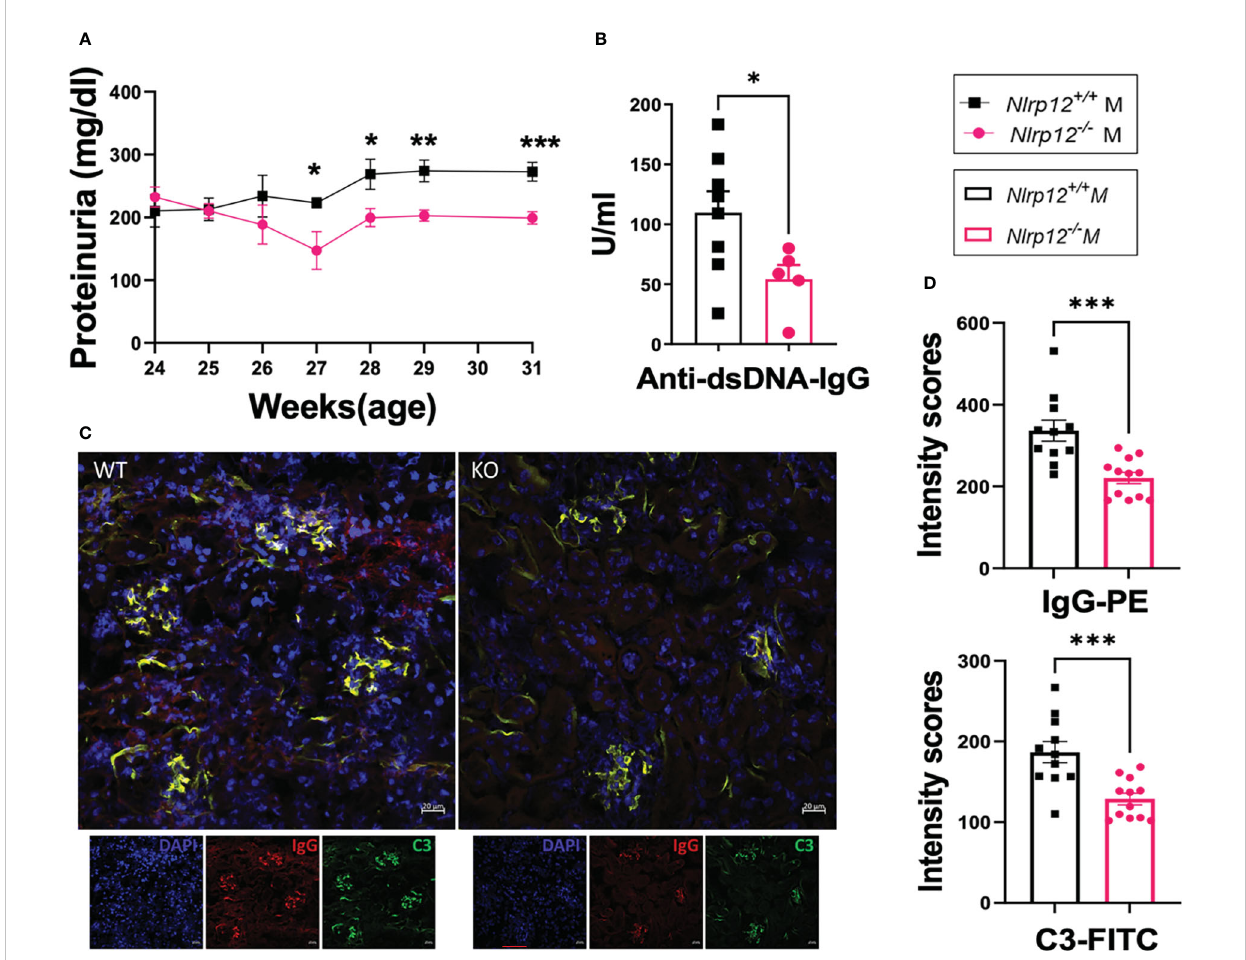
FIGURE 1 Nlrp12 de fi ciency ameliorates hallmarks of autoimmunity in male mice with Fas lpr -mediated systemic autoimmunity. The progression of systemic autoimmunity in a mouse model of ALPS and SLE was assessed in male Nlrp12 +/+ (WT) and Nlrp12 -/- (KO) B6/ lpr mice. (A) Level of proteinuria over time (n=6 or 8/group). (B – D) Endpoint analyses at 39 weeks of age. (B) Level of anti-double stranded (ds)DNA IgG antibodies. (C) Immunohistochemical stains of kidney sections showing the deposition of IgG (red) and C3 (green) with DAPI staining of nuclei (blue). Pictures were captured with a Zeiss LSM 880 confocal microscope. Bar, 20 m m. (D) Mean intensity scores of IgG-PE and C3-FITC fl uorescence as determined by ZEN 2.1 Lite software. Student ’ s t test was employed for the comparison between two groups. Data are shown as mean ± SEM. Signi fi cant differences were shown as *P<0.05, **P<0.01, and